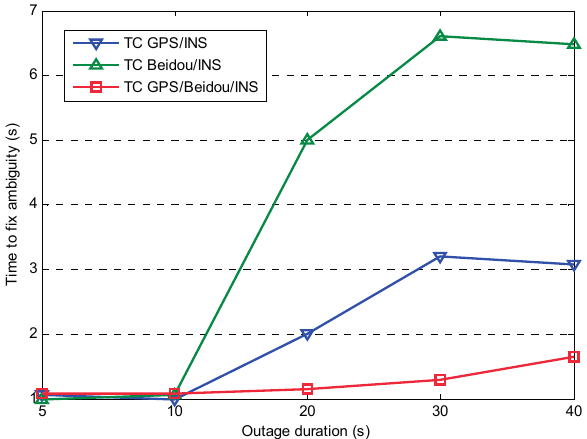
Figure 14. Time to fix ambiguity after different outage durations for different system